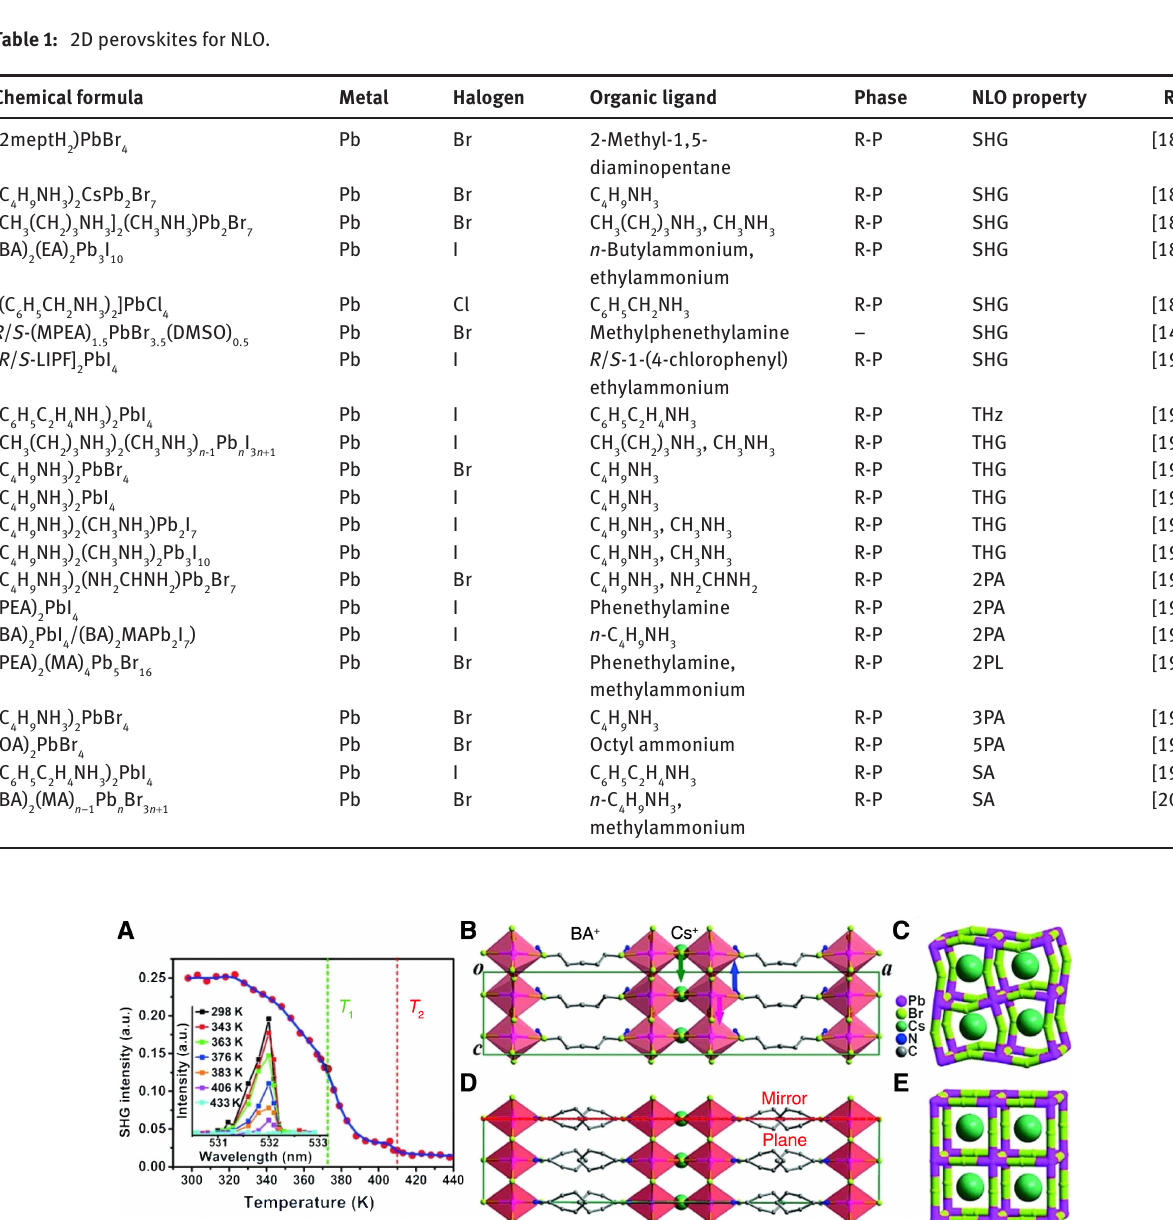
H NH ) CsPb Br . Inset: the SHG intensity as a function of wavelength at different 4 9 3 2 2 7 H NH ) CsPb Br at different temperatures. At 293 K: (B) viewed along the crystallographic b -axis 4 9 3 2 2 7